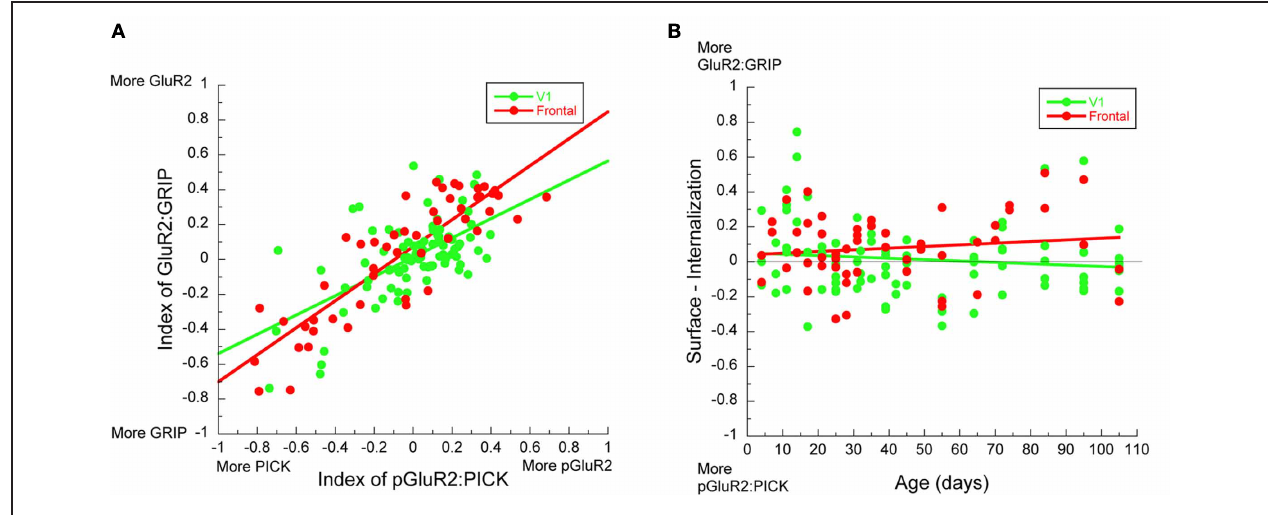
FIGURE 6 | Development of AMPA receptor in visual and frontal cortex. (A) There was a strong correlation between the indices for GluA2:GRIP and pGluA2:PICK1 in both visual (green symbols) ( r = 0 . 61, p < 0 . 0001) and